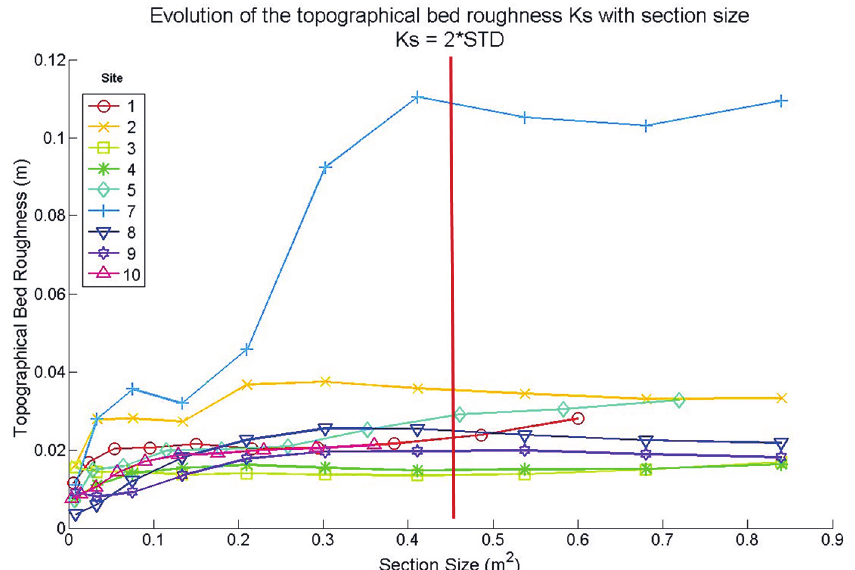
Figure 6. Standard deviation of the de-trended bed elevation variations (roughness) plotted against subsection areas for all sites of this study (Note site 7 has been included because it represents the greatest roughness and hence likely the most sensitive to changes in subsection